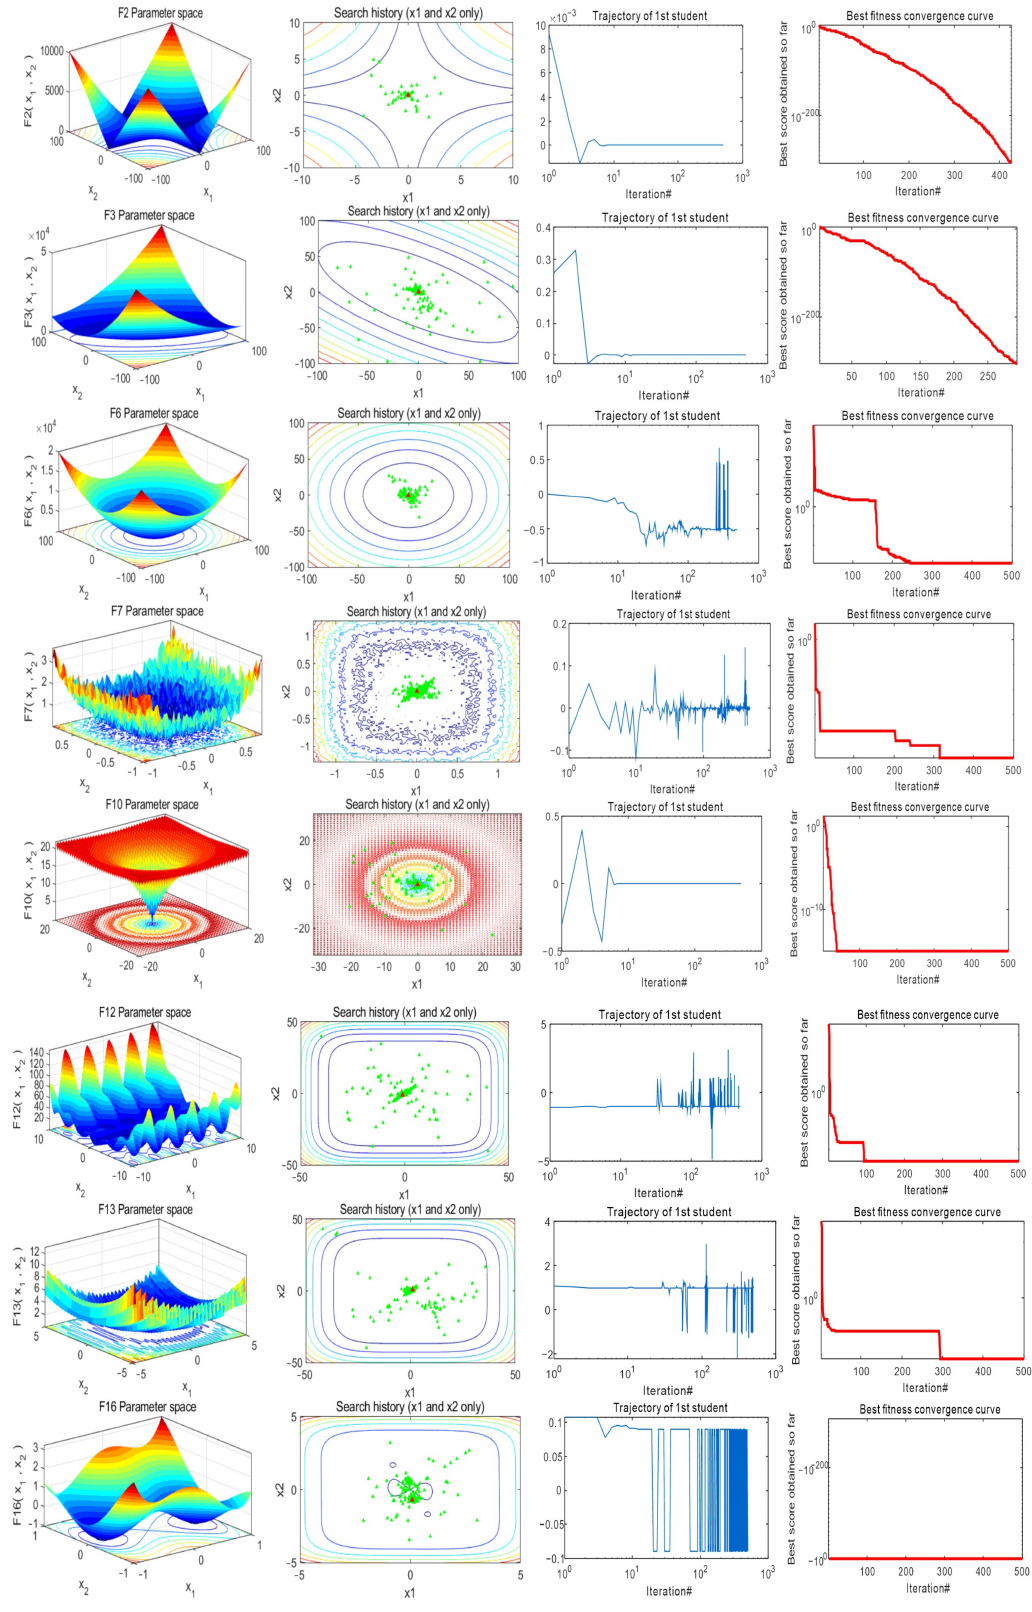
Figure 3. Results of MGTOA in 23 benchmark